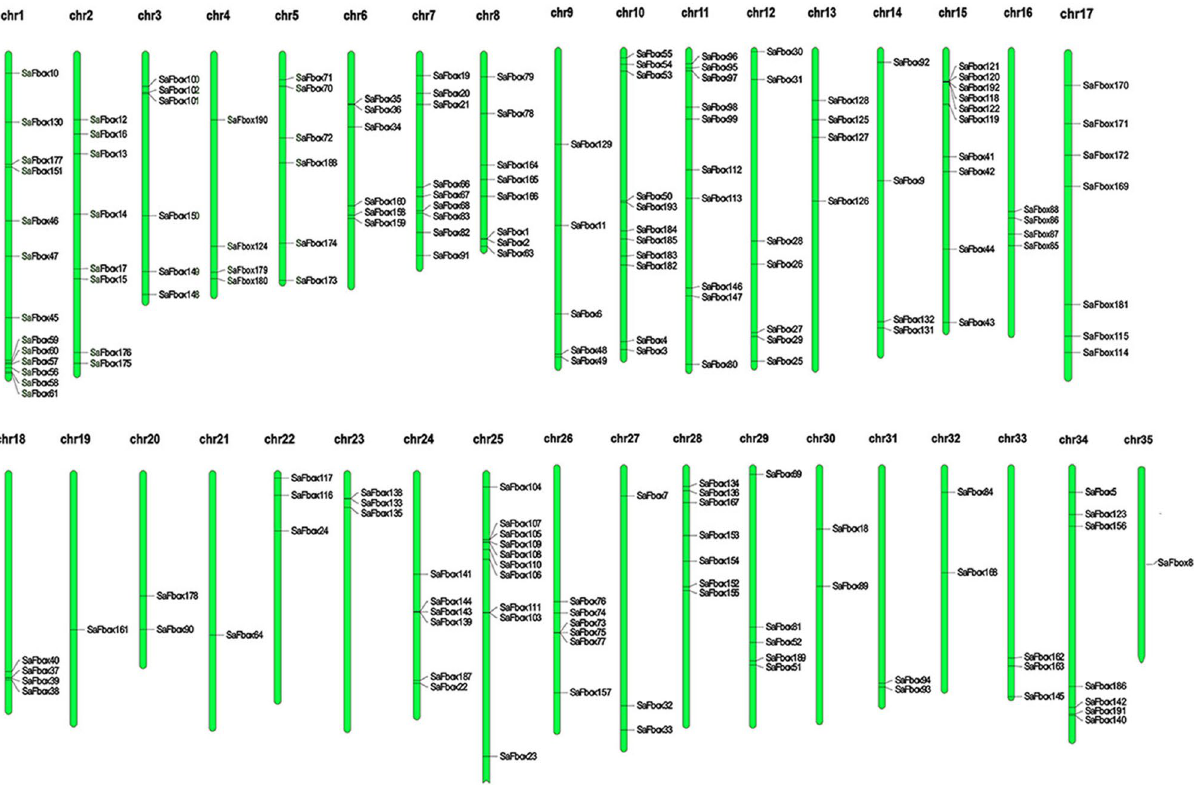
Figure 4. Chromosomal locations of SaFbox genes . A total of 193 SaFbox were distributed in 35 chromosomes. The chromosomes are drawn to scale and the chromosome numbers are indicated at the top of each. The gene names are shown on the right side of each chromosome corresponding to the position of each gene. Blue boxes represent different